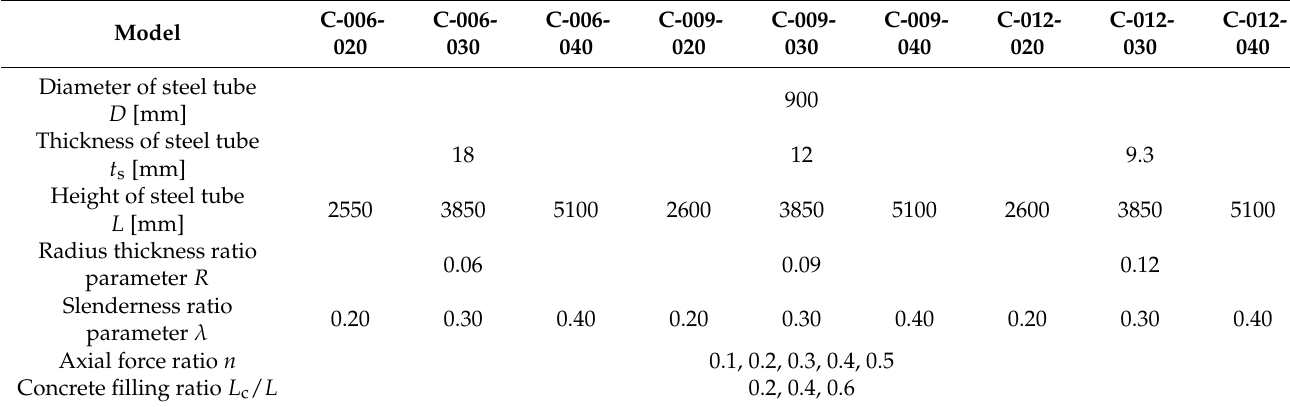
Table 1. Numerical model specifications.